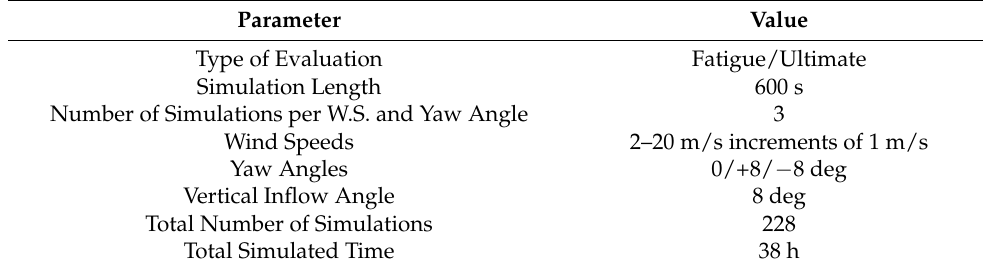
Table 3. IEC 61400-2 DLC 1.2 main set-up